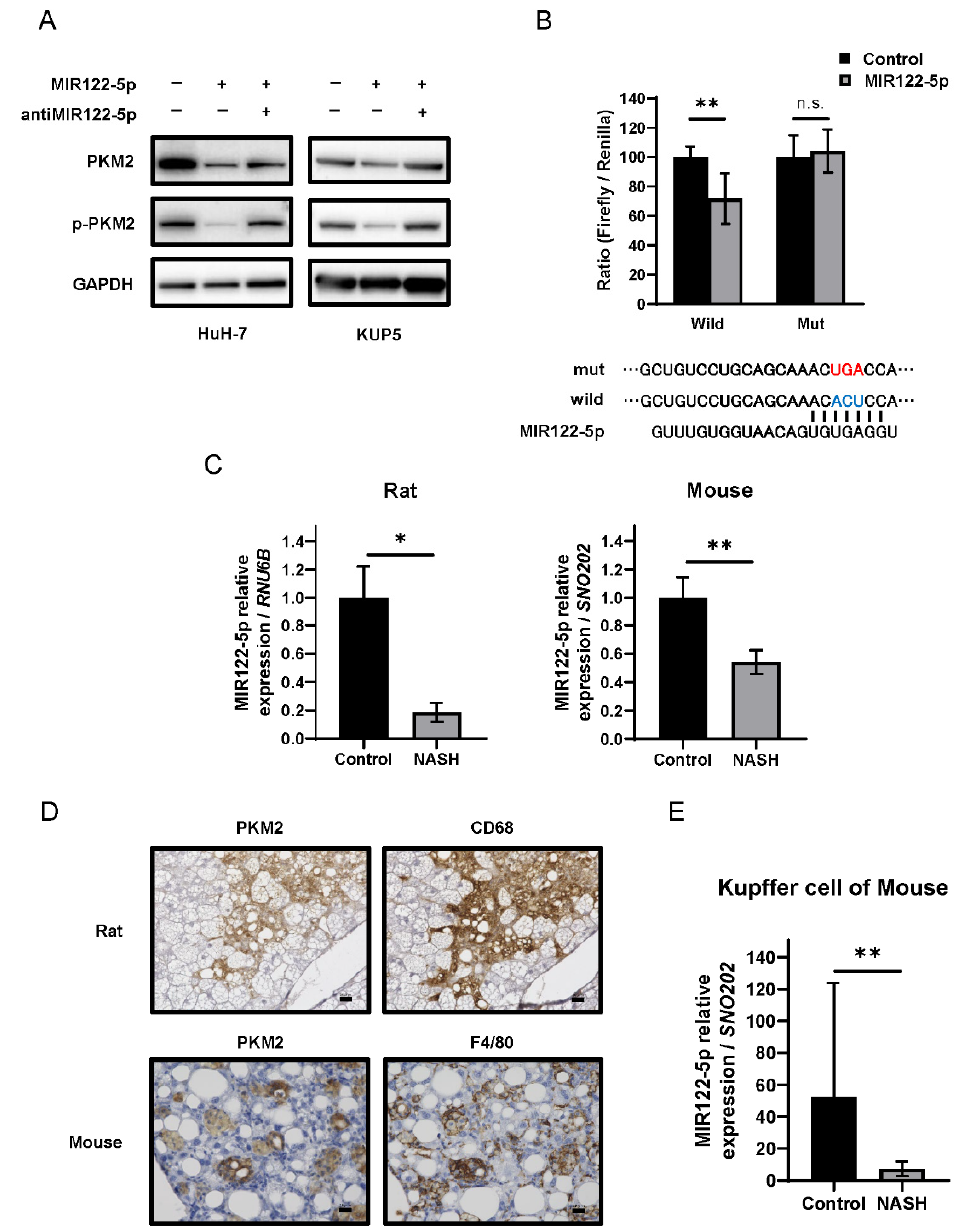
Figure 5. Association between miR-122-5p and PKM2 expression in Kupffer cells. ( A ) PKM2 and p- PKM2 expression under treatment with miR-122-5p or miR-122-5p inhibitor. The effect was examined in the HCC cell line (HuH-7) and Kupffer cell line (KUP5). Left, non-specific miRNA (Control; 20nM); middle, miR-122-5p mimic (20nM); right, miR-122-5p mimic and inhibitor (each 10nM). The effects were assessed at 72 h after treatment. GAPDH was used as an internal control. ( B ) The region of the 3’UTR of PKM mRNA complementary to the mature miR-122-5p. The lower segment indicates the predicted binding sites for miR-122-5p. Luciferase activities after co-transfection with control, miR-122-5p, and wild-type or mutant pMIR vectors harboring the predicted miR-122-5p binding site in the 3 ′ UTR of PKM . Note: Red text, mutant type; Blue text, wild type. ( C ) The expression of miR-122-5p in each non-alcoholic steatohepatitis (NASH) model. RNU6B and SNO202 were used as internal controls for rats and mice, respectively. ( D ) Immunohistochemistry (IHC) of PKM2 and Kupffer cell markers (CD68 for rats or F4/80 for mice). Scale bars = 50 µ m. ( E ) MiR-122-5p expression in Kupffer cells. SNO202 was used as a control. Values represent the mean ± SD. Note: * p < 0.05, ** p < 0.01, and n.s., not statistically significant vs.